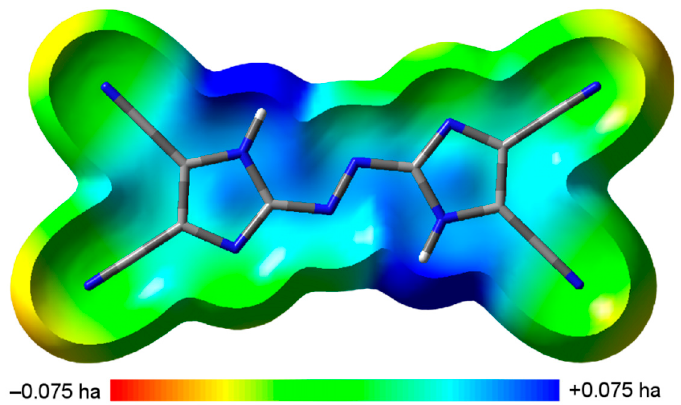
Figure 4. Calculated electrostatic potential of TCAD (view perpendicular to the plane).